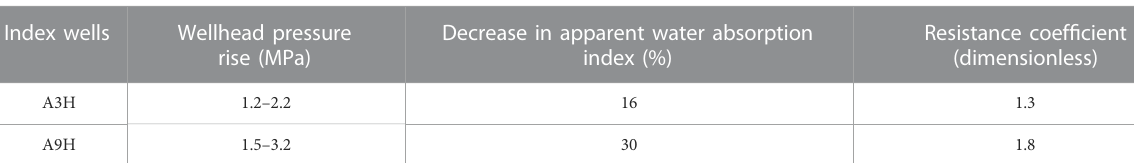
TABLE 9 Injection effectiveness evaluation.